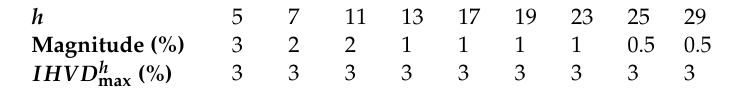
Table A2. A utility’s background voltage harmonics, and the corresponding limits [34]. h